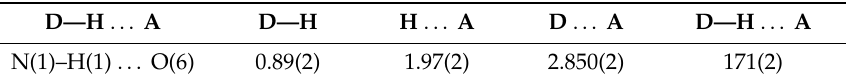
Figure 2. Unit cell of 1 viewed along the b axis showing the four molecules present along with their hydrogen bonded partners, and along the a axis showing that the molecules at the top left and bottom right are actually at right angles to those at the top right and bottom left. Table 3. Hydrogen bonding parameters for 1 (Å, °).